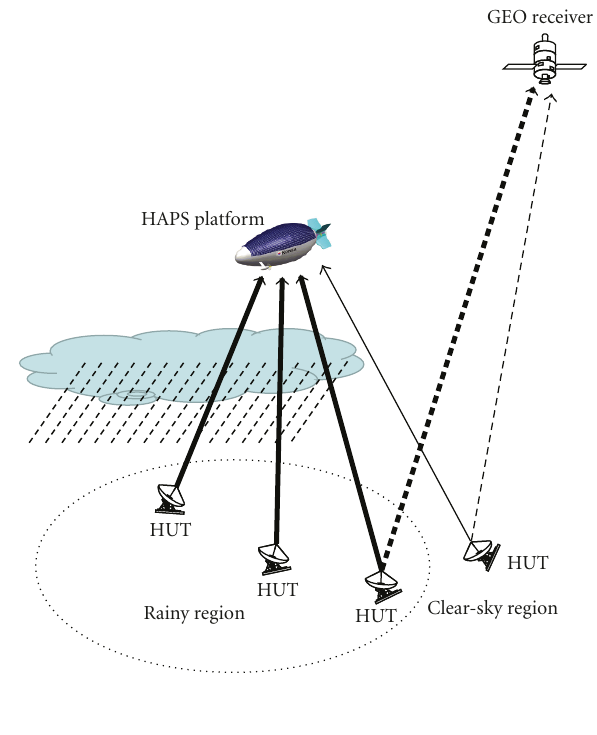
Figure 9: Scenario in the case of strong